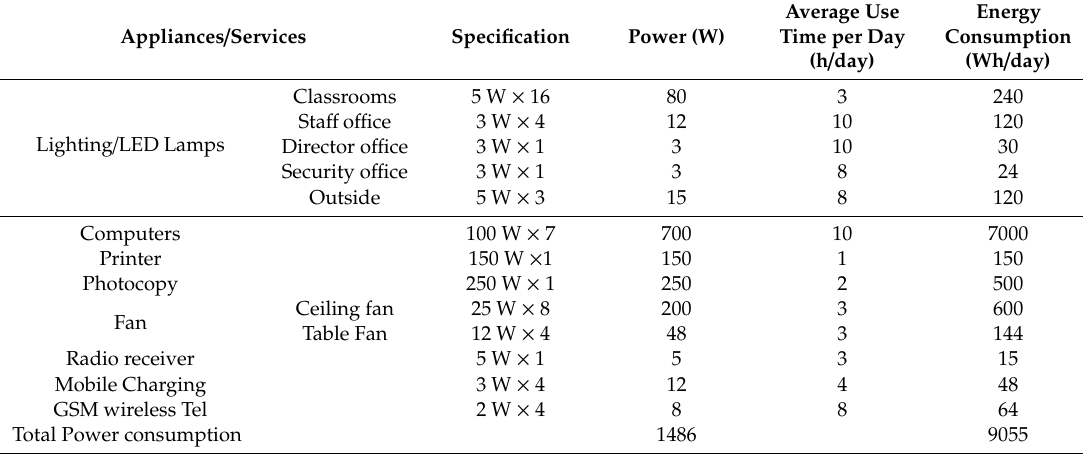
Table 2. Energy consumption of the school considering high e ffi cient appliances as compared to appliances with standard e ffi ciency